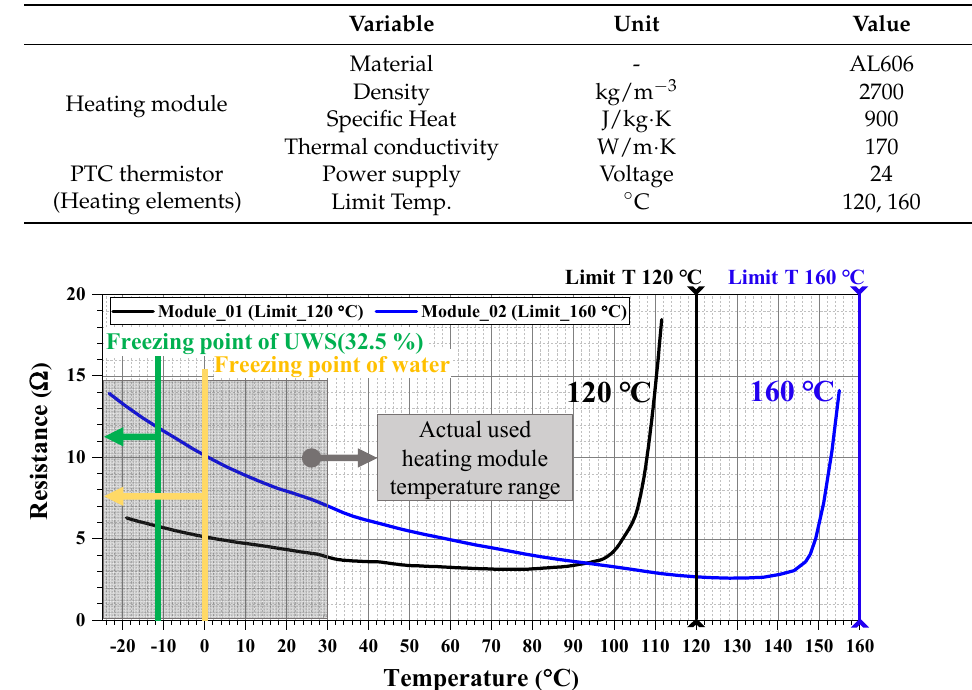
Figure 4. Heating element resistance according to temperature.